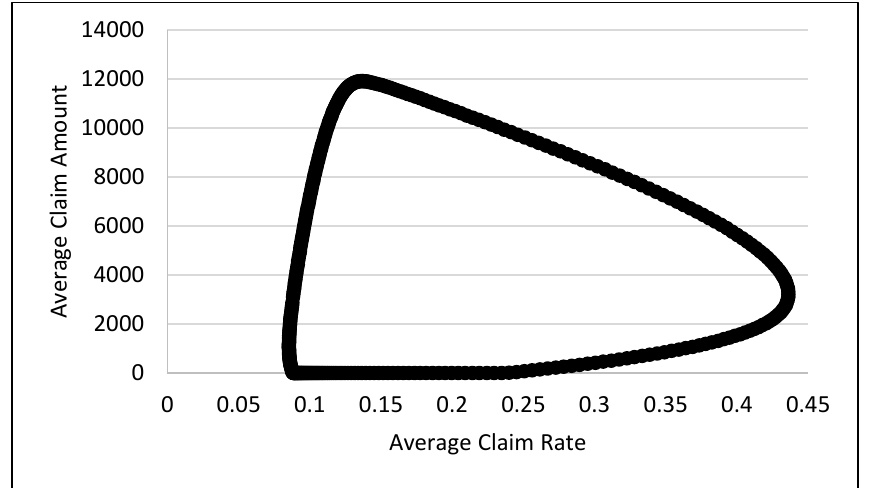
Fig. 1. The first prediction region for (𝑃 𝑐 , 𝐶 𝑎 ) [𝐾 = 1,𝑍 = 1, 𝐵 = 1,𝑀 = 1]